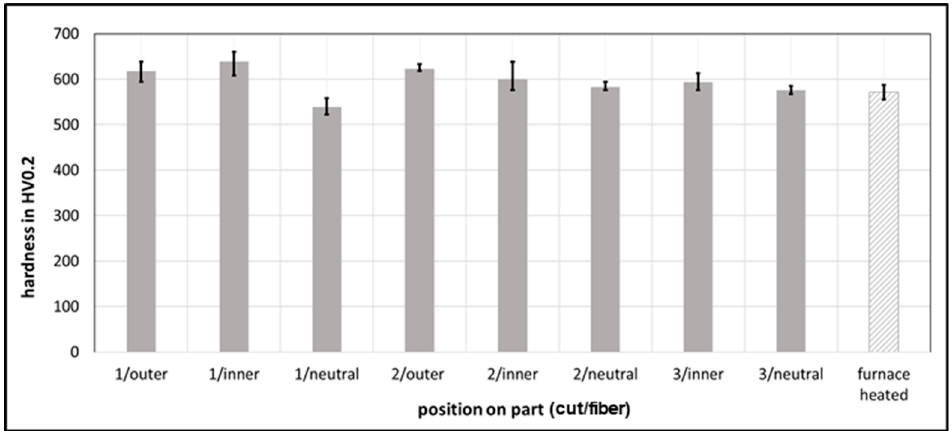
Figure 9. Comparison of hardness: part after conduction heating or furnace heating.